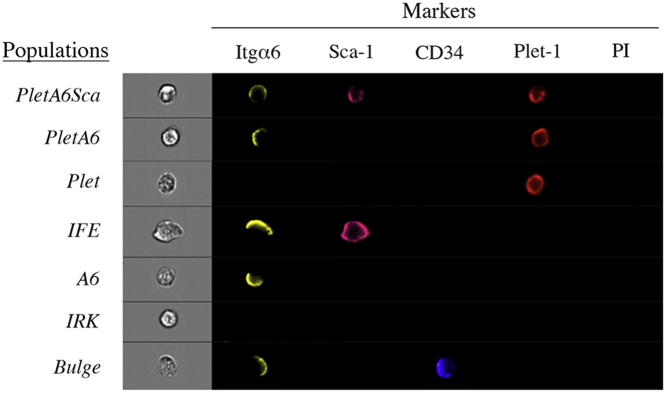
Single cell imaging of the different keratinocyte populations. Freshly isolated murine dorsal keratinocytes were stained with surface-antibodies against Sca-1, CD34, Itgα6 and Plet-1, after which single cell images were acquired using ImageStream flow cytometer. Propidium iodide (PI) was used to exclude dead cells. Polarized Itgα6 staining can be visualized on the cell surface, representing the part of the keratinocytes that is connected to the basal layer [2], [3]. In accordance to the flow cytometry dot plots (Fig. 2D) The population Plet-1 negative population IFE generally shows stronger Sca-1 staining than the Plet-1 positive population PletA6Sca. In addition, Plet-1 staining were more intense in the Plet population compared to PletA6 and PletA6Sca. A polarized cell-surface localization of the CD34 protein is seen at the at the opposite side of Itgα6, which can be visualized in Bulge.